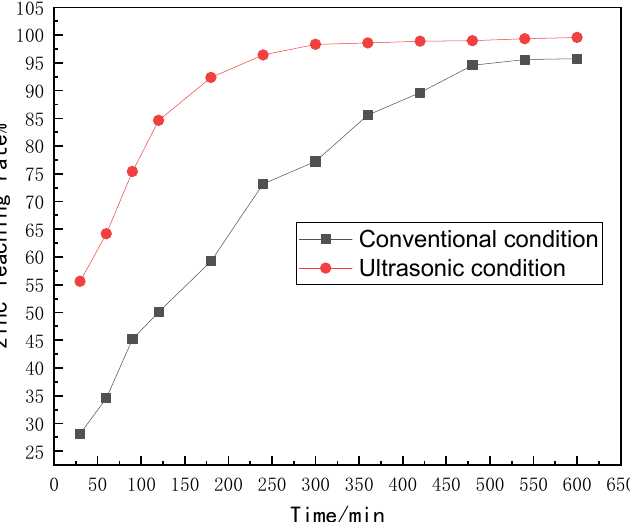
Figure 10. Effect of leaching time; conventional: leaching temperature = 90 °C, liquid ‐ solid ratio = 16:1, stirring speed = 400 rpm; ultrasonic: leaching temperature = 60 °C, liquid ‐ solid ratio = 12:1, ultrasonic power = 350 W.